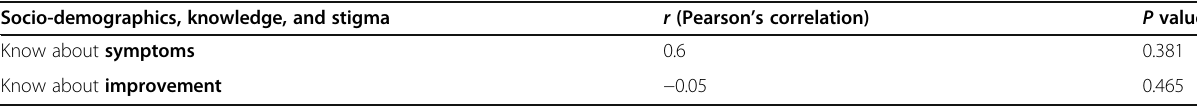
Table 4 Correlations of knowledge to